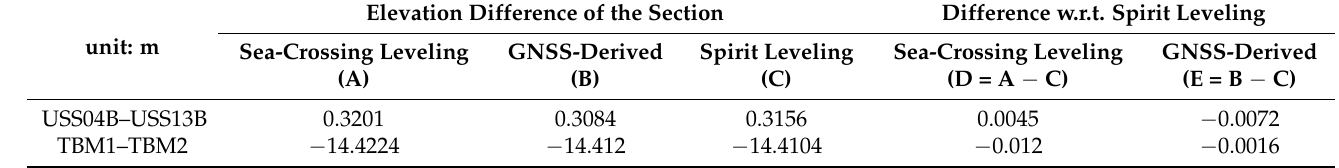
Table 4. Comparison of elevation differences at two surveying sections among sea-crossing leveling, GNSS-derived height determination, and spirit leveling.